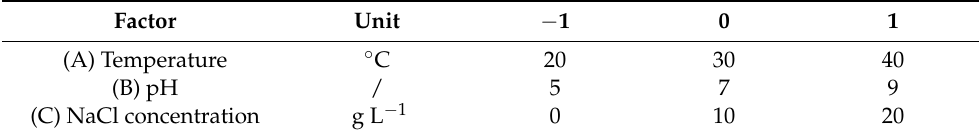
Table 2. Summary of experimental factors and